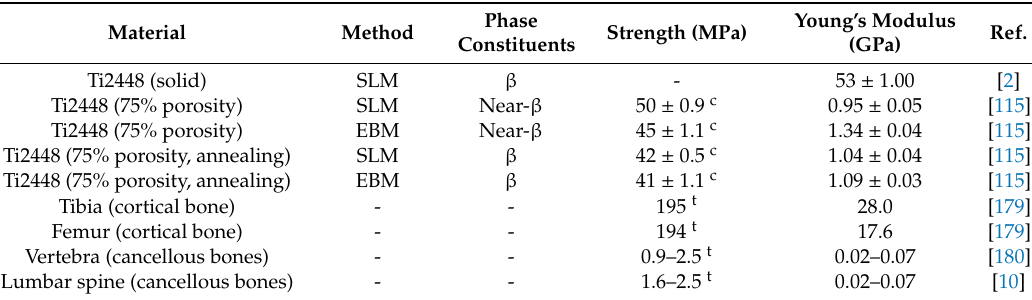
Table 2. Phase constituents, compressive strength, and Young’s modulus of electron beam melting (EBM)- and selective laser melting (SLM)-produced Ti–24Nb–4Zr–8Sn alloy (Ti2448) and human